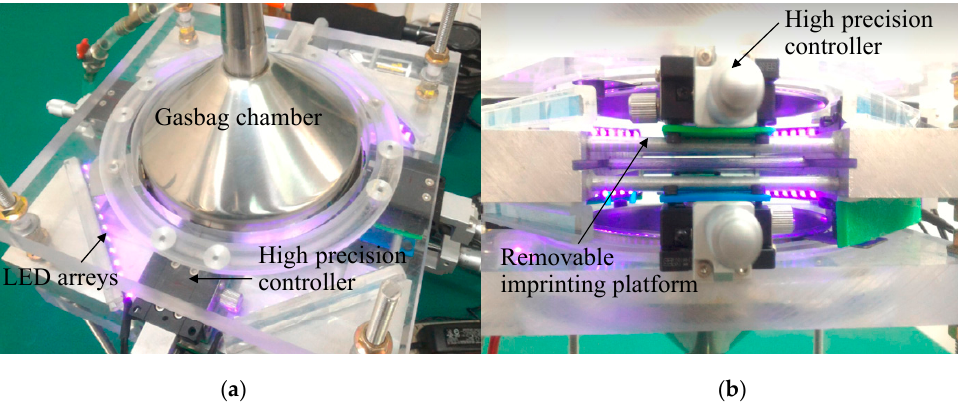
Figure 5. Innovative gasbag-assisted dynamic forming system. ( a ) Top view ( b ) Side view.